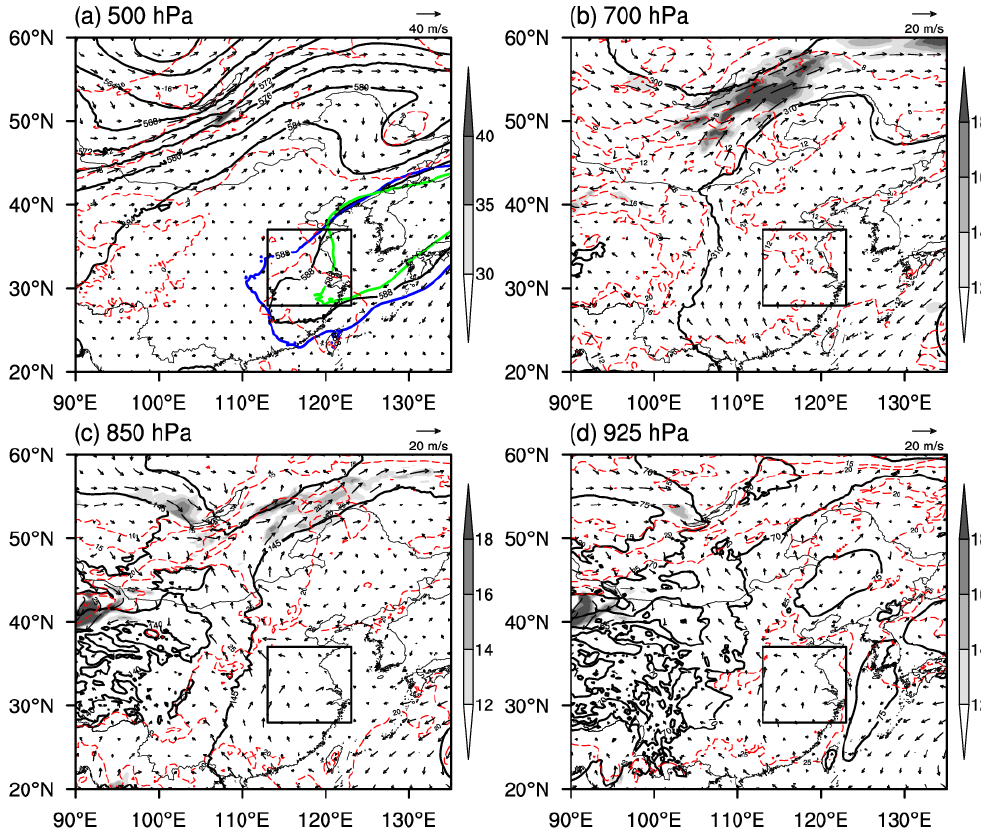
Figure 4. Geopotential heights (black solid line: 1200 UTC 26 July; blue solid line: 0000 UTC 26 July; green solid line: 0000 UTC 27 July), temperature (red dotted line), and wind field (arrow: wind direction; shadow: full wind speed) at 1200 UTC on 26 July 2018 at the level of ( a ) 500 hPa; ( b ) 700 hPa; ( c ) 850 hPa and ( d ) 925 hPa. The black rectangles mark the analysis region shown in Figure 1.